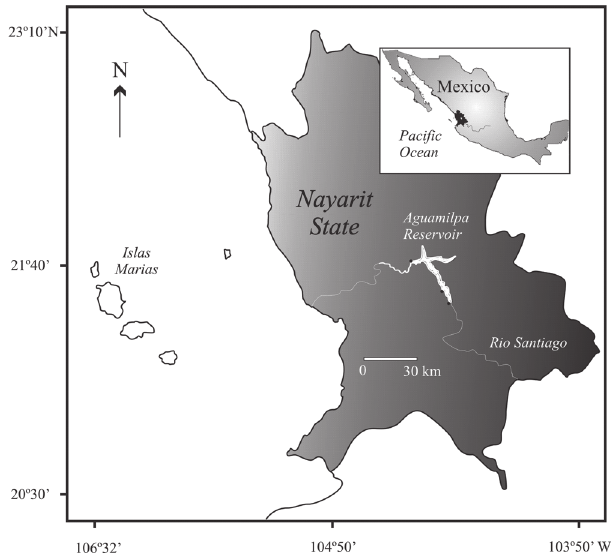
Fig. 1. Aguamilpa Reservoir, Nayarit, Mexico. Black dots indicate landing sites and sampling